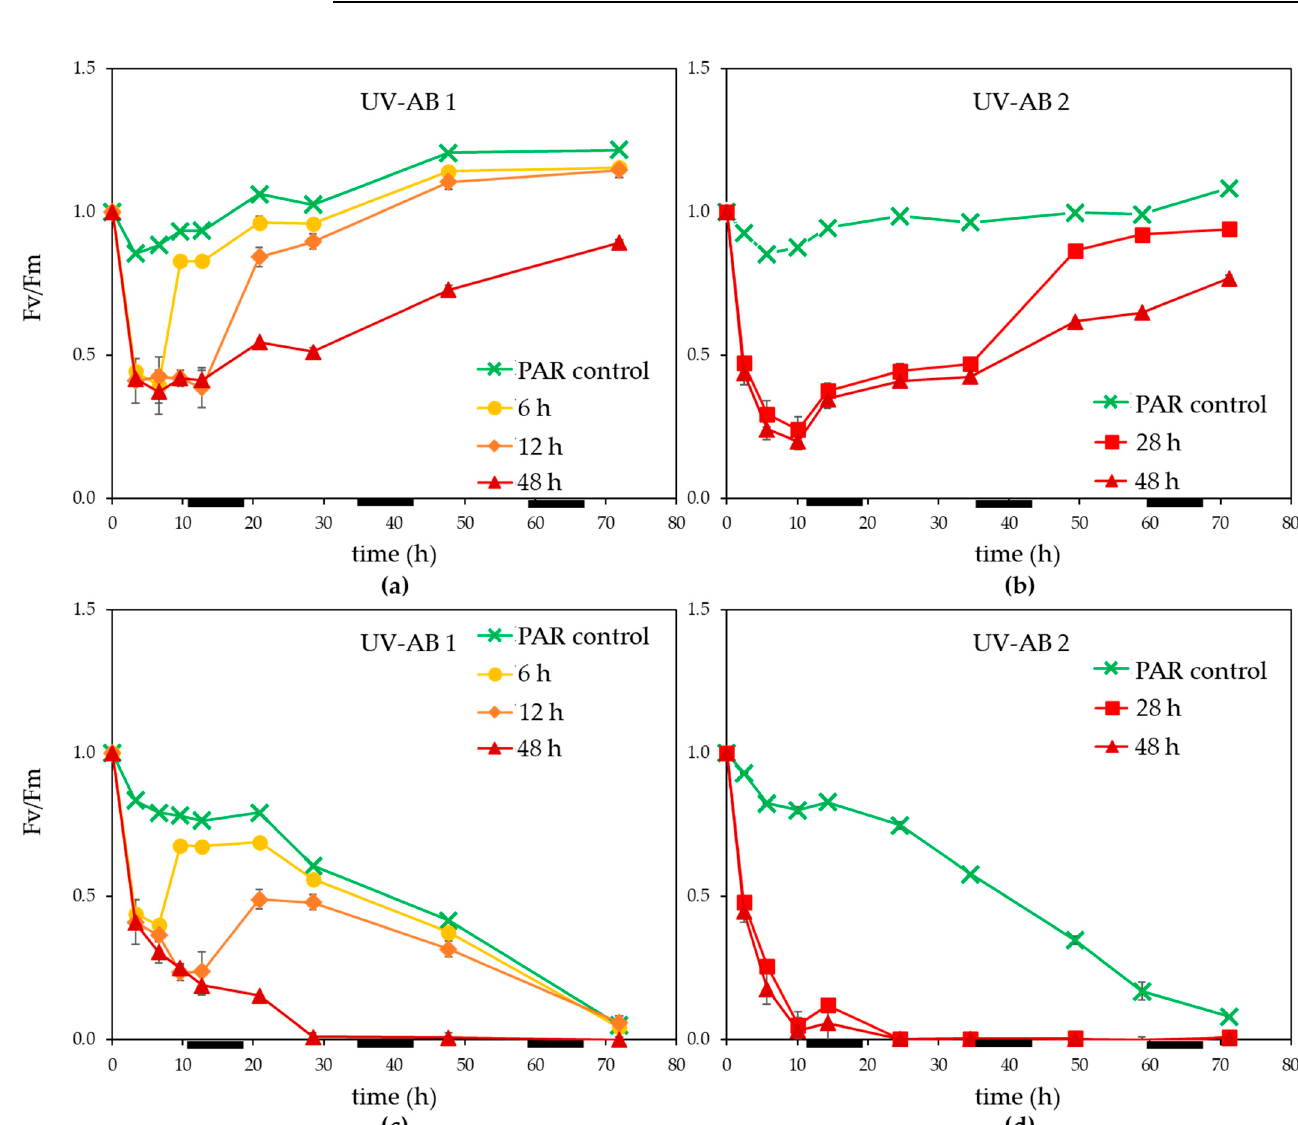
Figure 2. Photosynthetic efficiency (Fv/Fm., normalised to starting value) for ( a , b ) non-infected controls, ( c , d ) infected M. polaris under UV-AB exposure during ( a , c ) experiment 1 and ( b , d ) experiment 2. Average values with standard deviation ( n = 2 except for experiment 2 PAR-only control where n = 1). The horizontal black bars indicate the dark period. Infected M. polaris cultures started declining about 24 h post infection (p.i.), inde- pendent of the UV-exposure except that the 48 h UV-AB treatment showed a larger reduc- tion (Figure 1c,d). The time until the release of the progeny viruses (latent period) was not affected by the UV-AB treatment. There was some variation between the two experiments (Figure 3) but still within the published latent period for this virus–host model system [42,52] and similar for UV-treated and PAR-only controls.